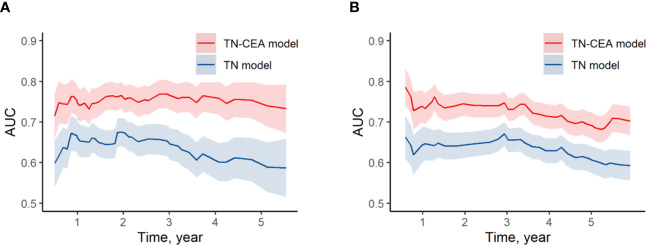
Time-dependent AUC of models. (A) Time-dependent AUC of TN model and TN-CEA model in training set. (B) Time-dependent AUC of TN model and TN-CEA model in validation set. TN model, the model includes the T stage and the N stage. TN-CEA model, the model includes T stage, N stage, and postoperative CEA.